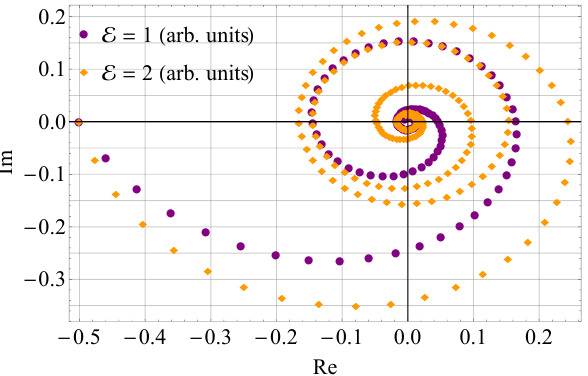
( t ) , presented on the complex plane for two values of E . 18